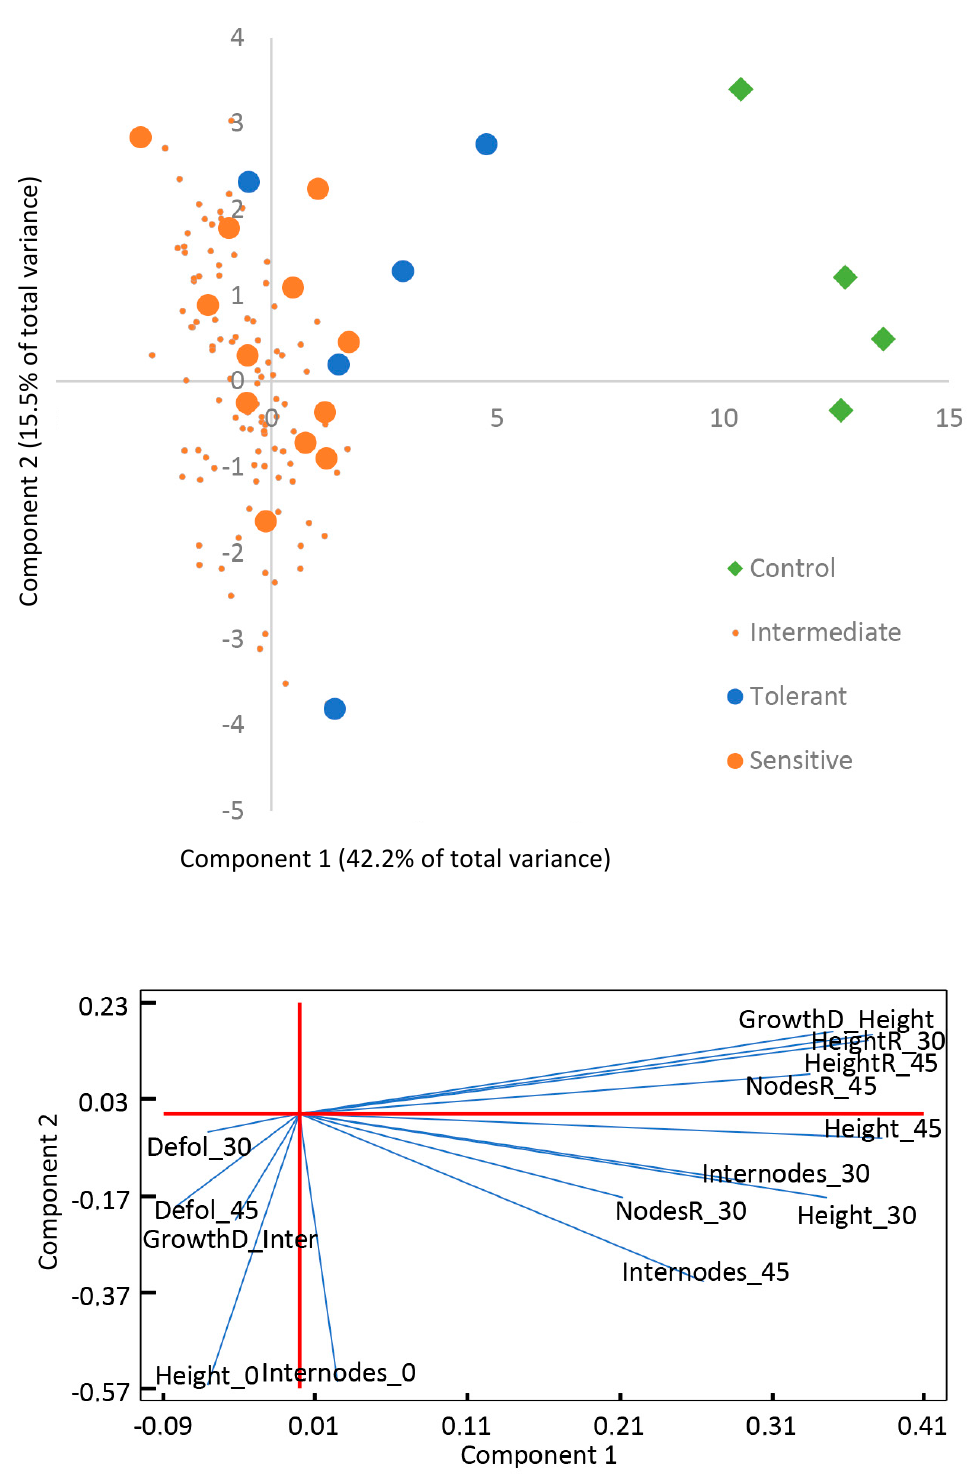
Figure 1. Principal component analysis of the morphological variables measured. A representation of the contribution the variables to each component is included.